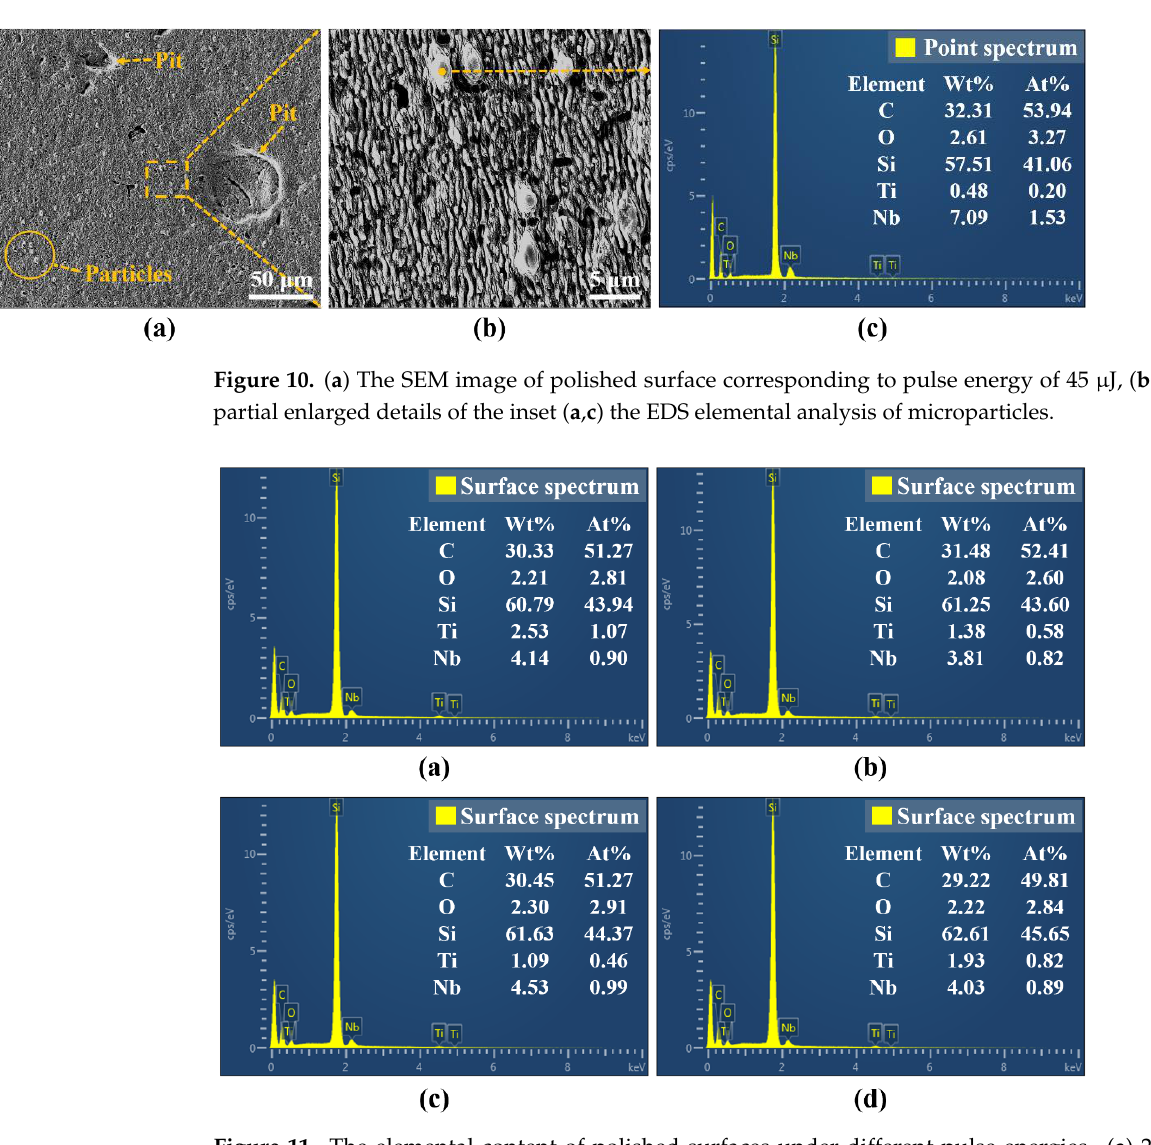
Figure 9. Polished surface morphologies and local magnifications under different pulse energies. ( a ) 20 μJ, ( b ) 25 μJ, ( c ) 35 μJ, ( d ) 45 μJ. The insets ( a1 ), ( b1 ), ( c1 ) and ( d1 ) were the partial enlarged details of the insets ( a – d) , respectively. The insets ( a2 ), ( b2 ), ( c2 ) and ( d2 ) were the partial enlarged details of the insets ( a1 ), ( b1 ), ( c1 ) and ( d1 ), respectively.